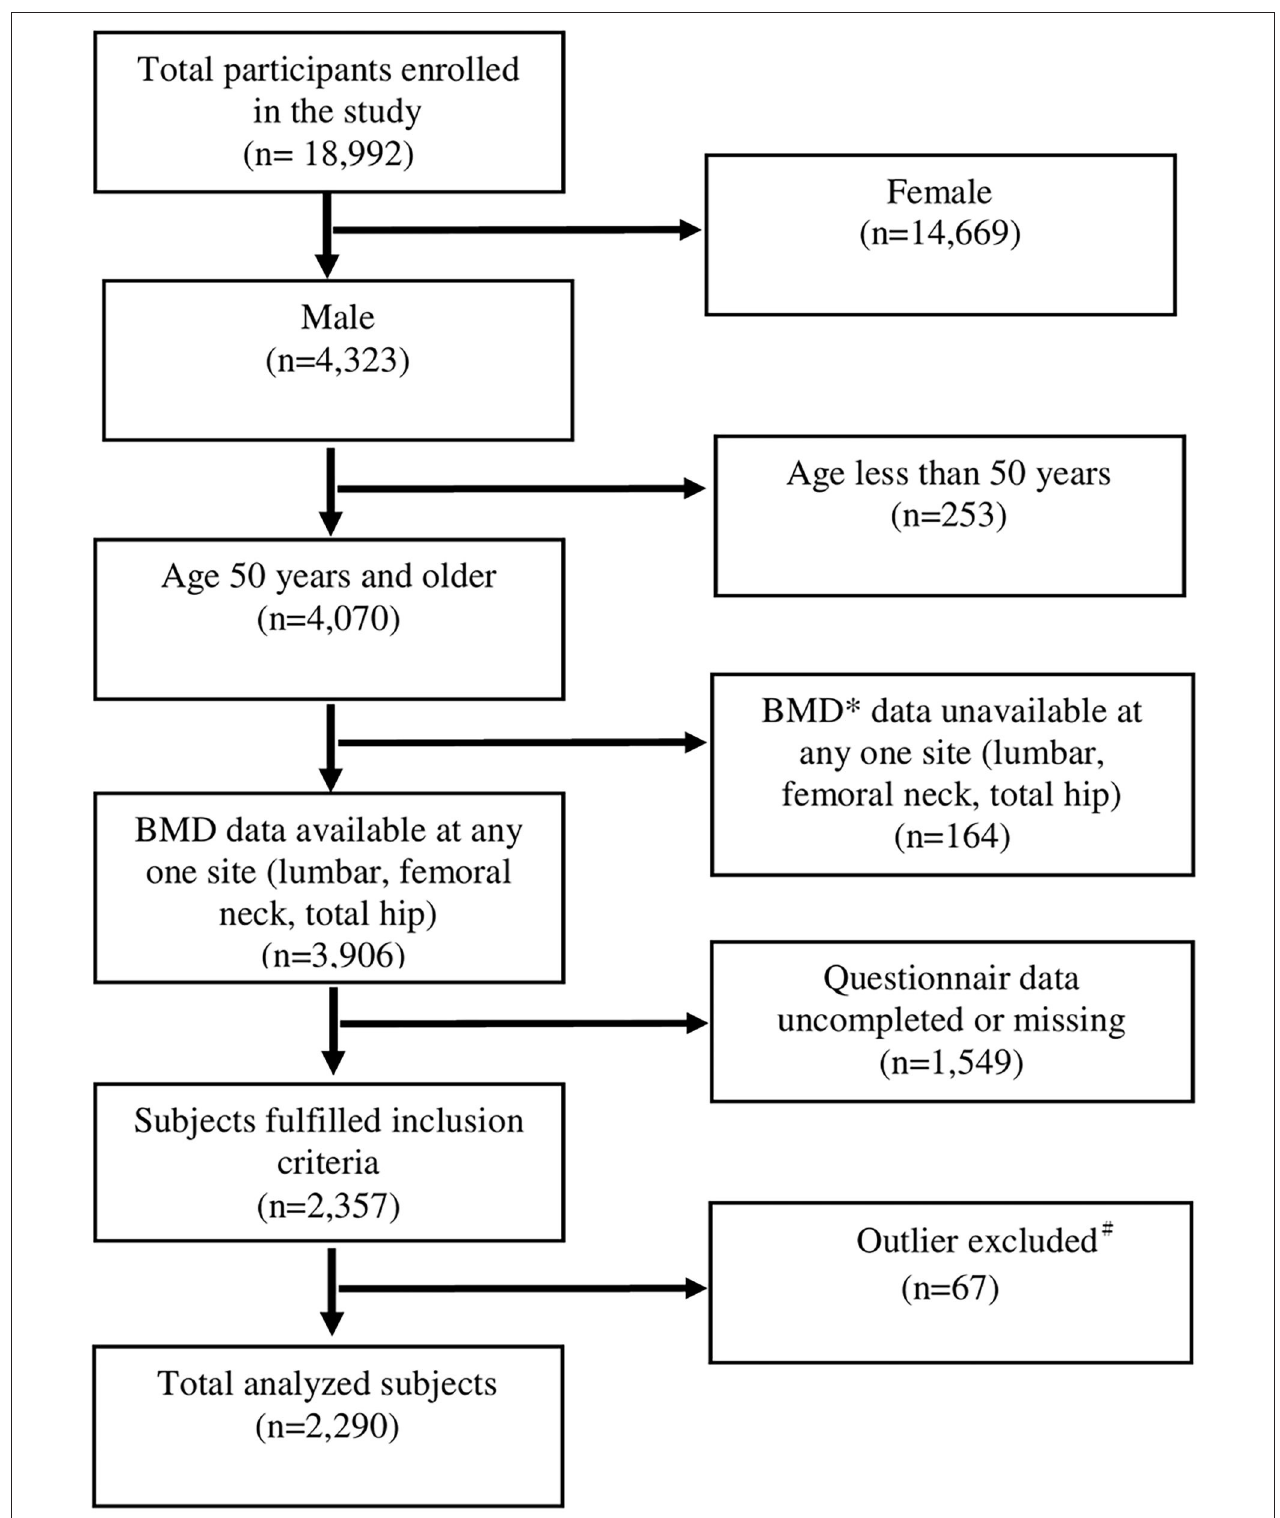
FIGURE 1 | Inclusion of the participants in the study. *Participants whose BMD was missing at any one site for any reasons were excluded. # Participants with extreme values (deviating from the mean by more than three times the standard deviation), including demographics and BMD were excluded for data analysis.